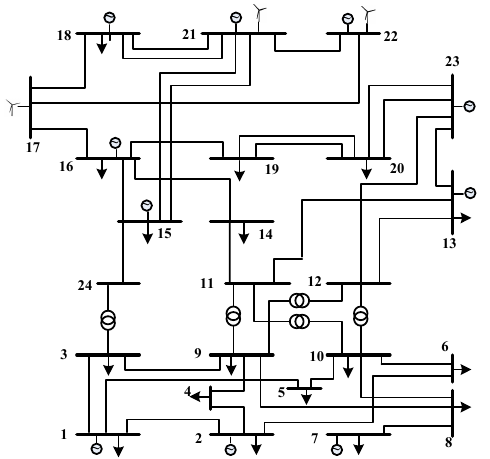
Figure 5. IEEE 24-bus reliability test